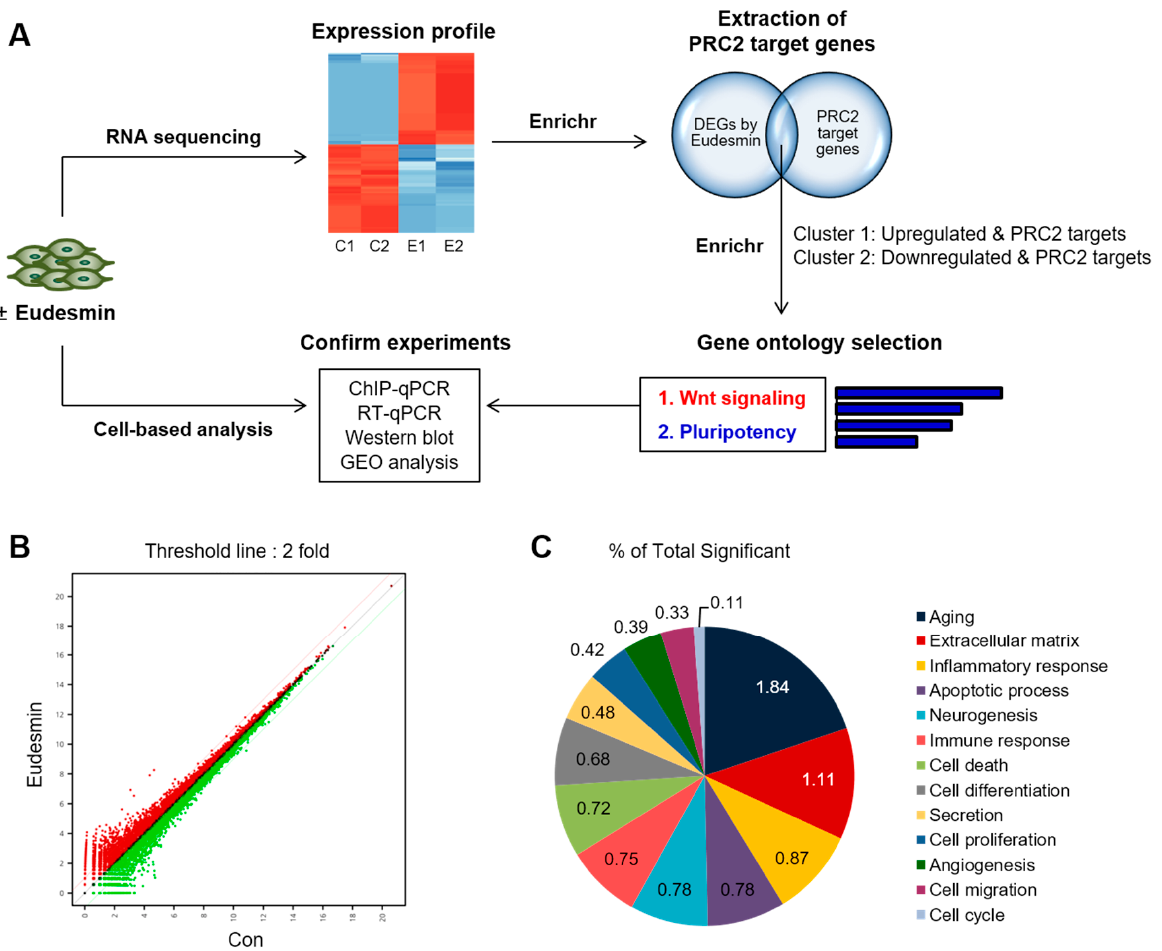
Figure 1. RNA sequencing analysis of eudesmin-treated 10T1/2 mesenchymal stem cells ( A ) Analysis flow to identify epigenetic effects of eudesmin. ( B ) Scatter plot of showing differentially expressed genes between control group and eudesmin-treated group (cut-off threshold: fold change > 2). ( C ) Gene category plot showing significantly changed genes related to each ontology (cut-off threshold: fold change > 2, p -value < 0.01)